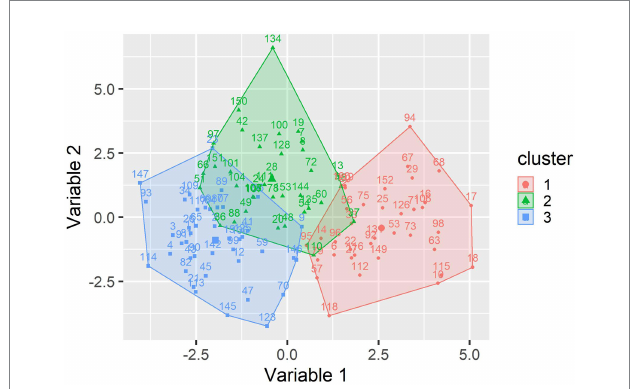
FIGURE 1 Initial cluster solution projected into two dimensions.